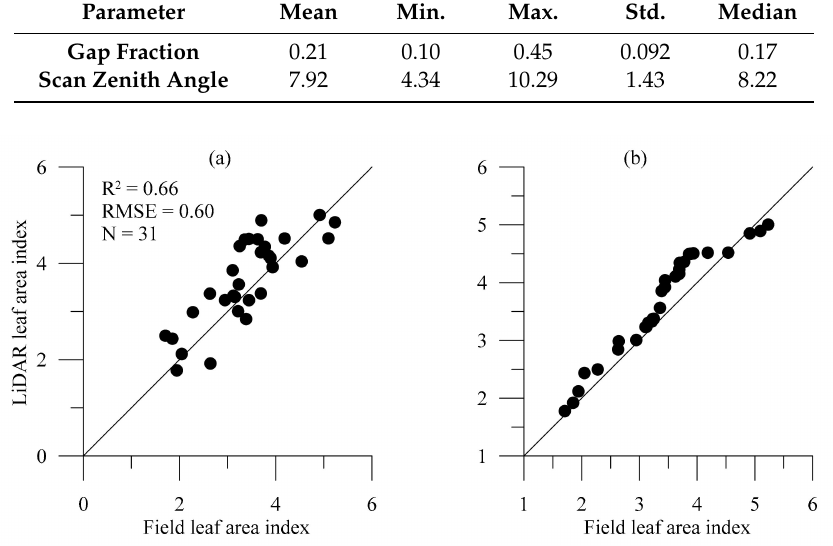
Figure 9. Comparison of estimated result with the field LAI. ( a ) Scatter and ( b ) Q–Q plot. At the plot level, the scan zenith angle of LiDAR data is limited to a small dynamic range, as shown in Table 2, which means that, at the plot level, it is di ffi cult to invert the physical model to derive the plot-wise extinction coe ffi cient. This is the main reason we inverted the model at the tile level and used the mean extinction coe ffi cient obtained from tile-level LiDAR